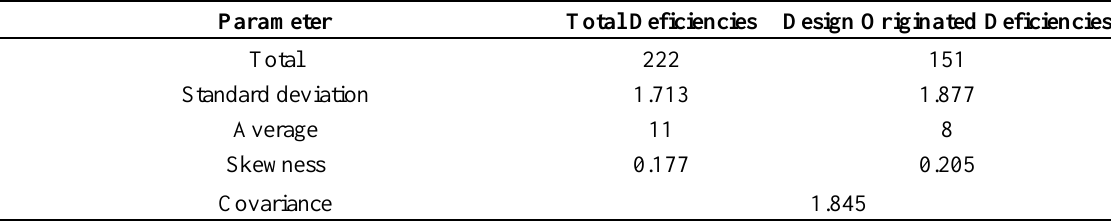
Table 5. Statistical factors for the total deficiencies and those originating in